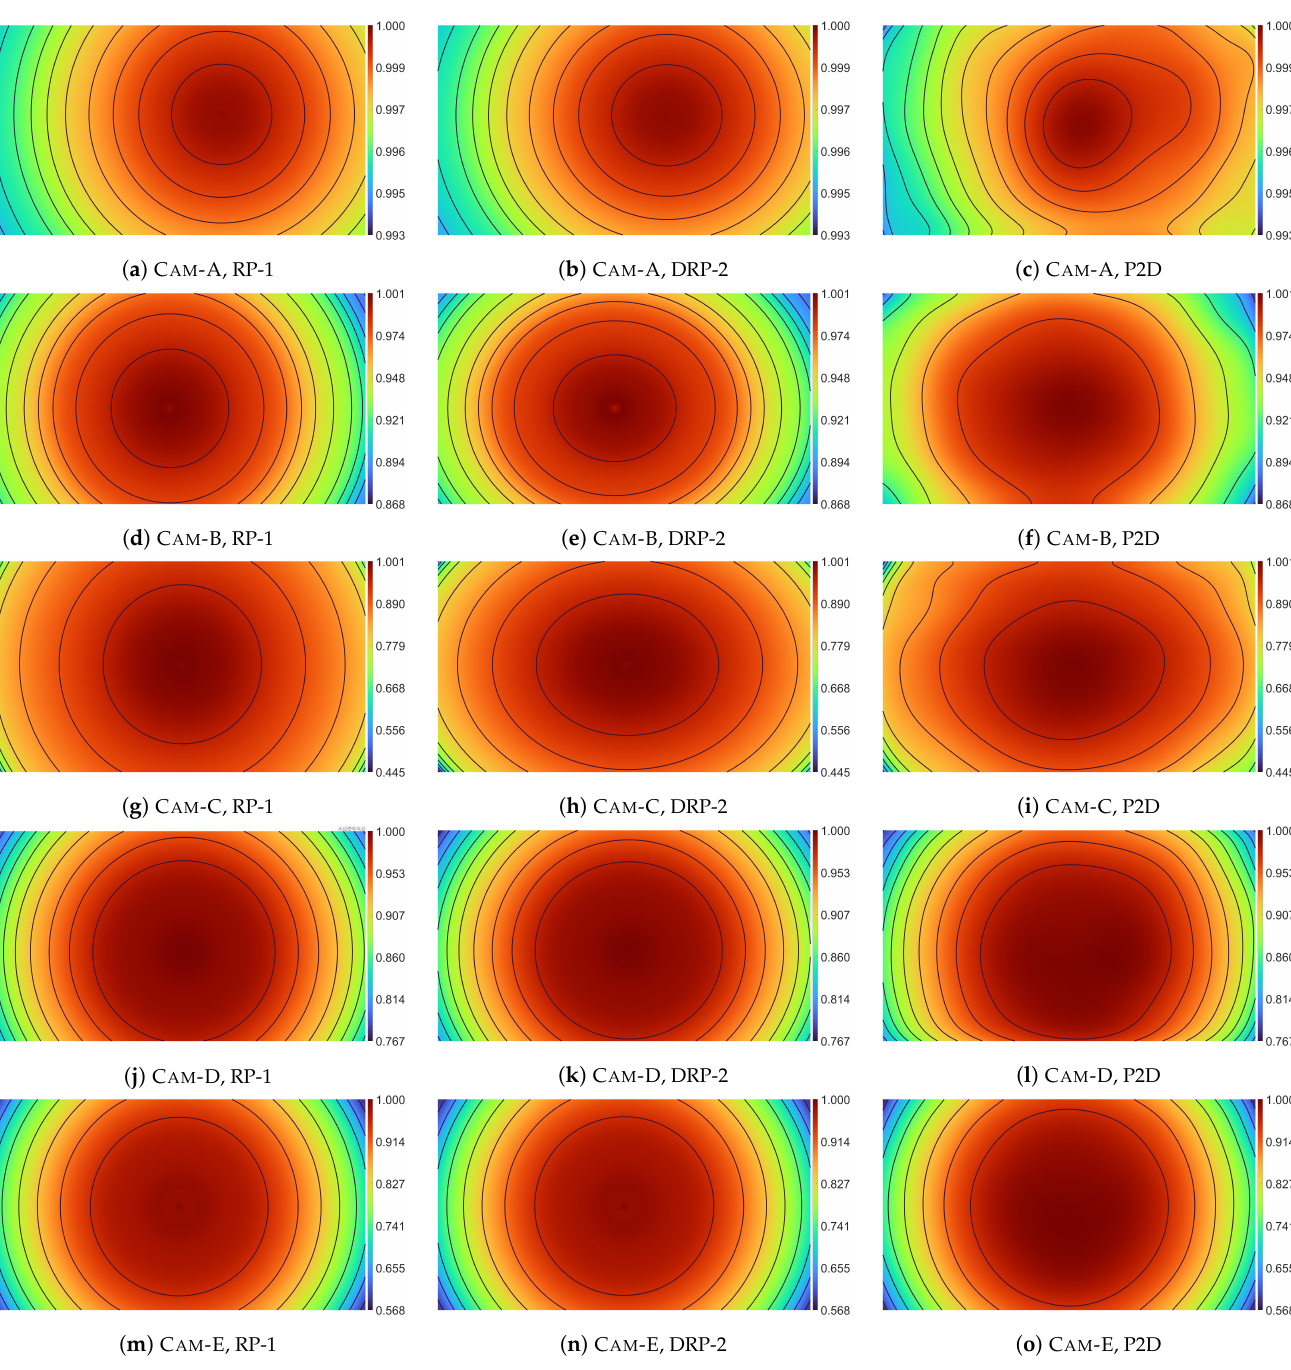
Figure 4. Comparison of the vignetting estimates (cid:101) V obtained form the RP-1 ( left column), DRP-2 ( central column), and P2D ( right column)